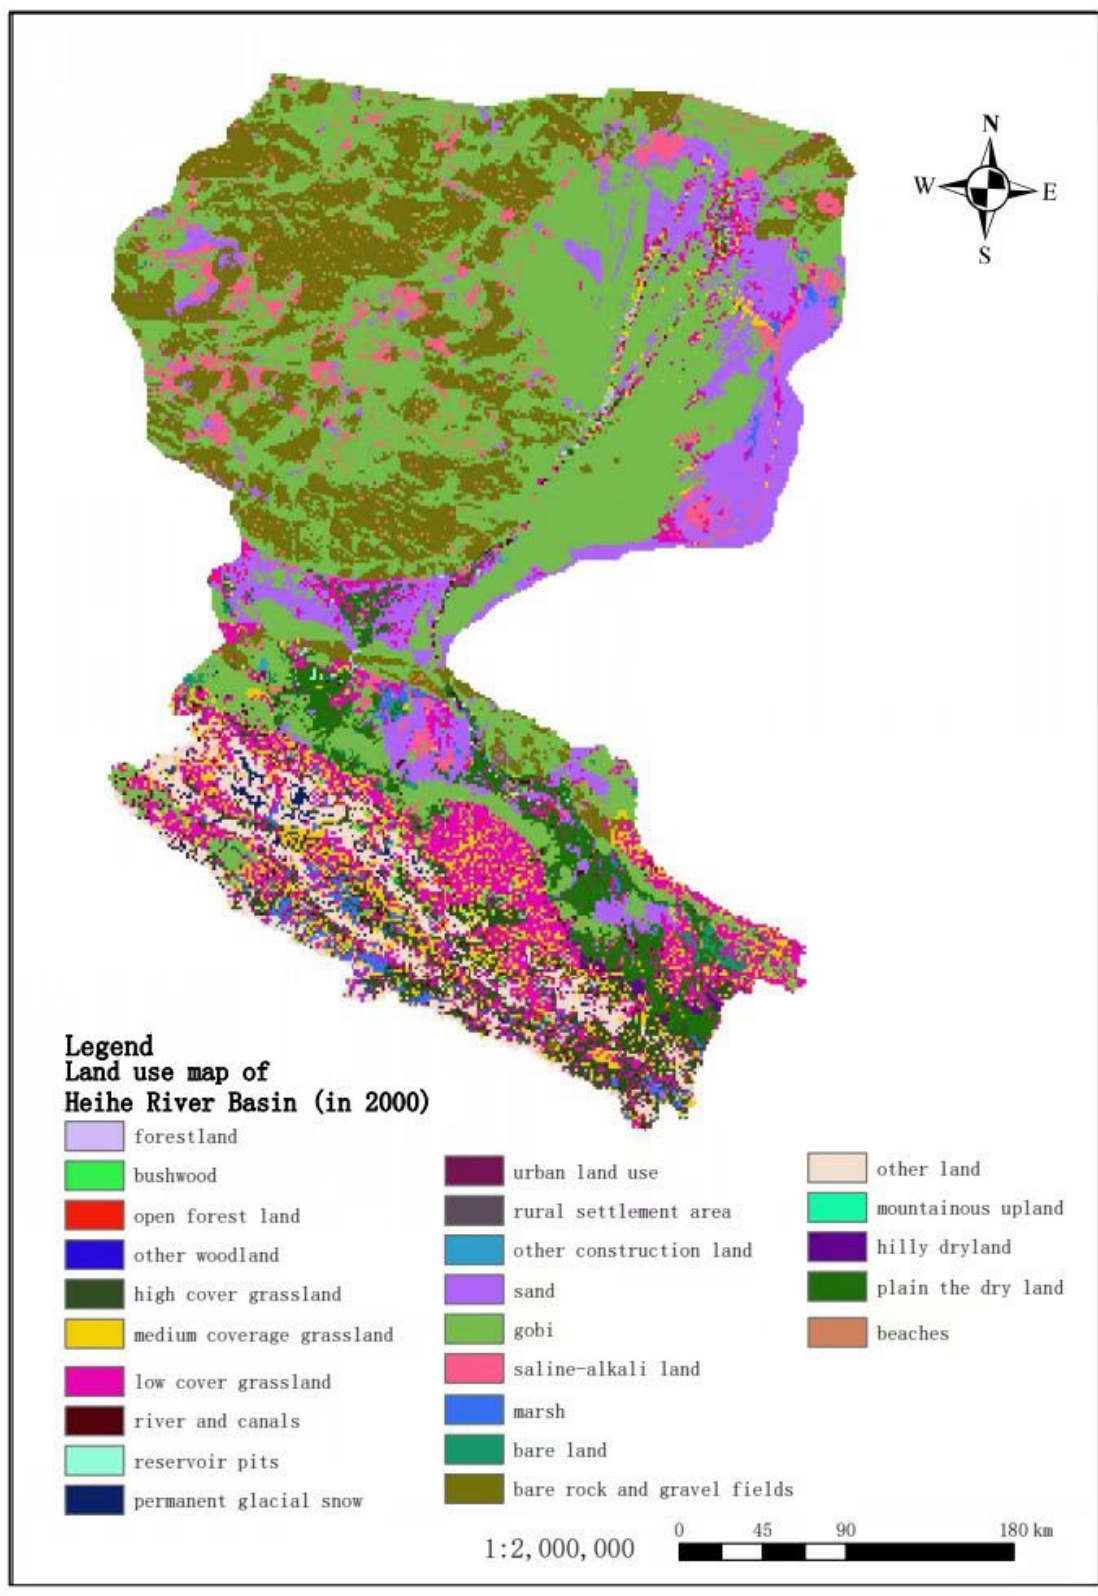
Figure 2. Land cover map of the Heihe River Basin.